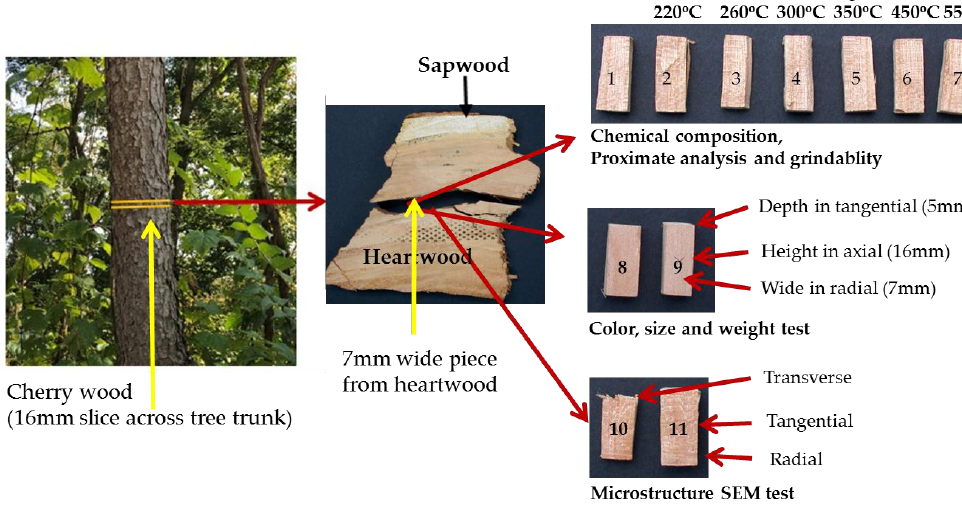
Figure 1. Sample preparation and sample arrangement.